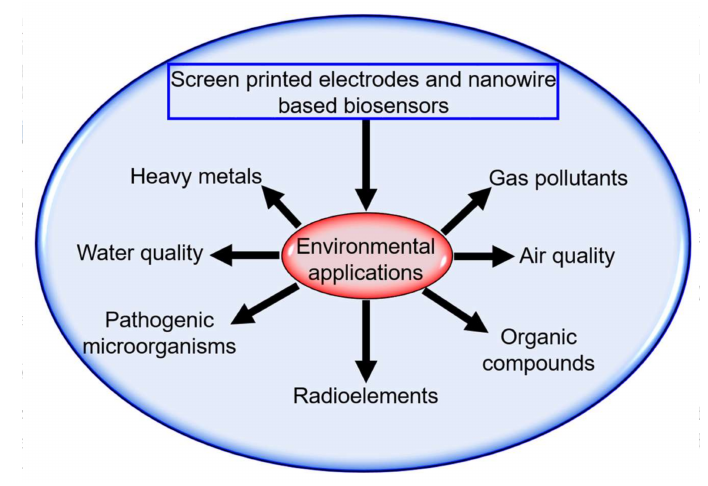
Figure 4. Environmental applications of SPEs and nanowire-based